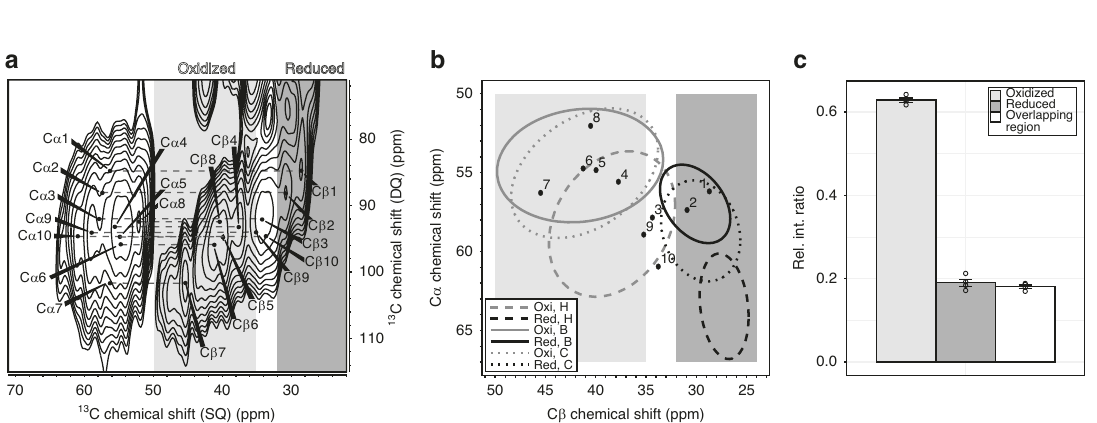
Fig. 1 Design of GBC RNC constructs, solution-state NMR investigation of full-length GBC, and LC-MS/MS investigation of RNC fragments. a Different lengths of GBC were fused at the N-terminal with a 10x histidine puri fi cation tag (white) and at the C-terminal with a 17-amino acid SecM sequence (dark gray). Numbering excludes the N-terminal methionine of GBC. GBC residues 1 – 32 (light blue), 33 – 43 (blue). 13 C-labeled Cys residues are marked with an asterisk (*) and highlighted in yellow. Number of GBC RNCs residues are given from the Peptidyl transferase center (PTC) to the N-terminus excluding the 10x histidine puri fi cation tag ( Δ PTC residues). b Lengths of the RNC construct s shown on the full-length GBC structure (PDB 4W9A) and 2D backbone 1 H- 15 N-HSQC NMR spectrum of cysteine residues of full-length GBC reduced (red) and after oxidation with Cu(II) (black). Cysteine residues not changing position after oxidation (Cys18, Cys109) or that could not be unambiguously identi fi ed due to overlapping signals (Cys32) were labeled only once. The complete 1 H- 15 N-HSQC NMR spectrum is shown in Supplementary Fig. 3. c C α and C β chemical shifts of the six cysteines within full-length GBC reduced and after oxidation with Cu(II) compared to values derived from a chemical shift database 24 . Ellipses contain 90% of the corresponding chemical shifts of each group 24 (H = helix, B = β -strand, C = coil). The spectral region for oxidized C β cysteines is highlighted in light gray, and for reduced cysteine in dark gray. The overlapping region of both states is shown in white. d Fragment spectrum of the tryptic peptide GFQGHAYECSSDAPNLQPYFSR (precursor m / z 695.54 (4 + )) from U32SecM C18 with a glutathione modi fi cation on Cys18. e Fragment spectrum of the tryptic peptide GFQGHAYECSSDAPNLQPYFSR (precursor 835.03 (3 + ) m / z ) from U32SecM C18 with a nitroso modi fi cation on Cys18. f Fragment spectrum of the tryptic peptide CNSIRVDSGCWMFSTPVWISQAQGIR (precursor m / z 980.46 (3 + )) from U43SecM with a loop-linked disul fi de bond (Cys32 – Cys41). Matched fragment ions are indicated by dashes in the sequence and respective labels on peaks. g Overview of cysteine oxidation states ( S -nitrosylation, S - glutathionylation, disul fi de bonding) of the NCs of all RNCs (U32SecM, U43SecM, and U78SecM and mutants) as observed by LC/MS-MS (Supplementary Table 1). Trypsin cleavage site is shown as dashed line, disul fi de bond as yellow line.